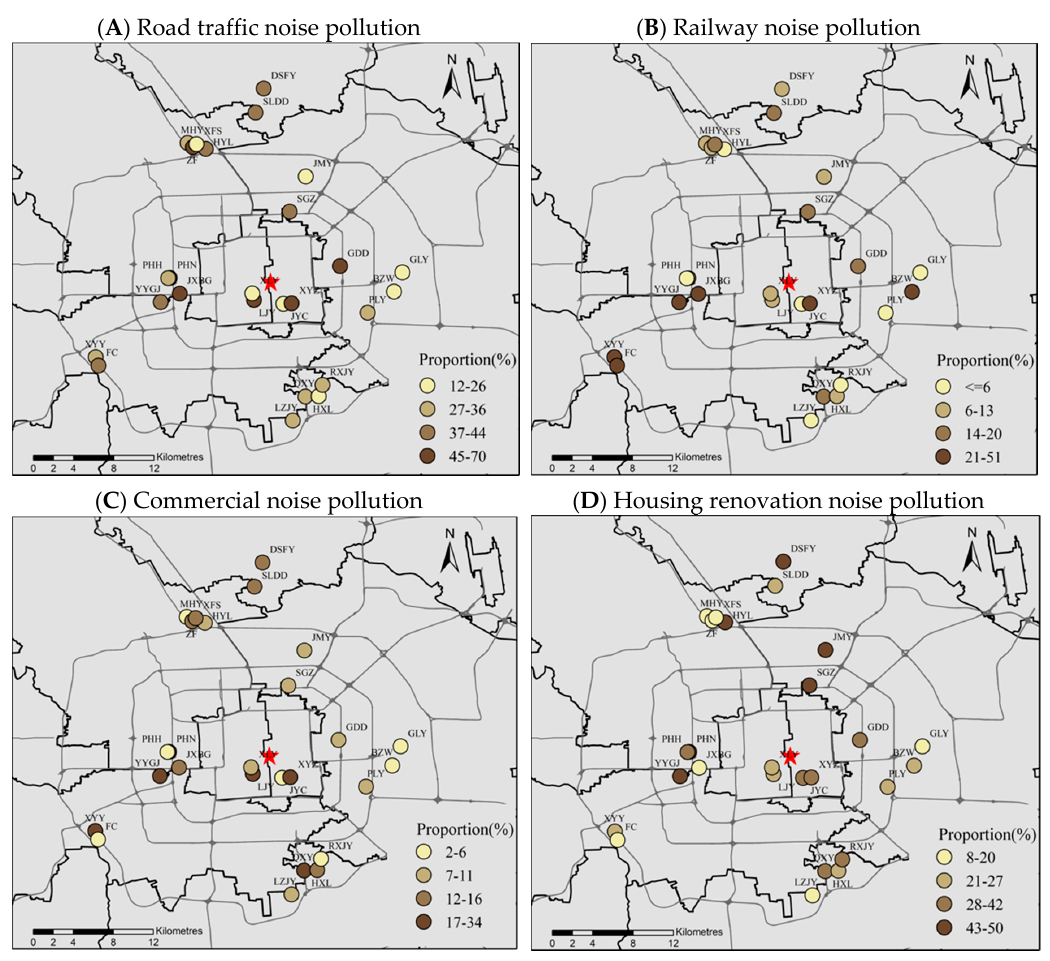
Figure 3. Spatial distribution of the population (%) reporting high or very high noise pollution at the community level in Beijing.